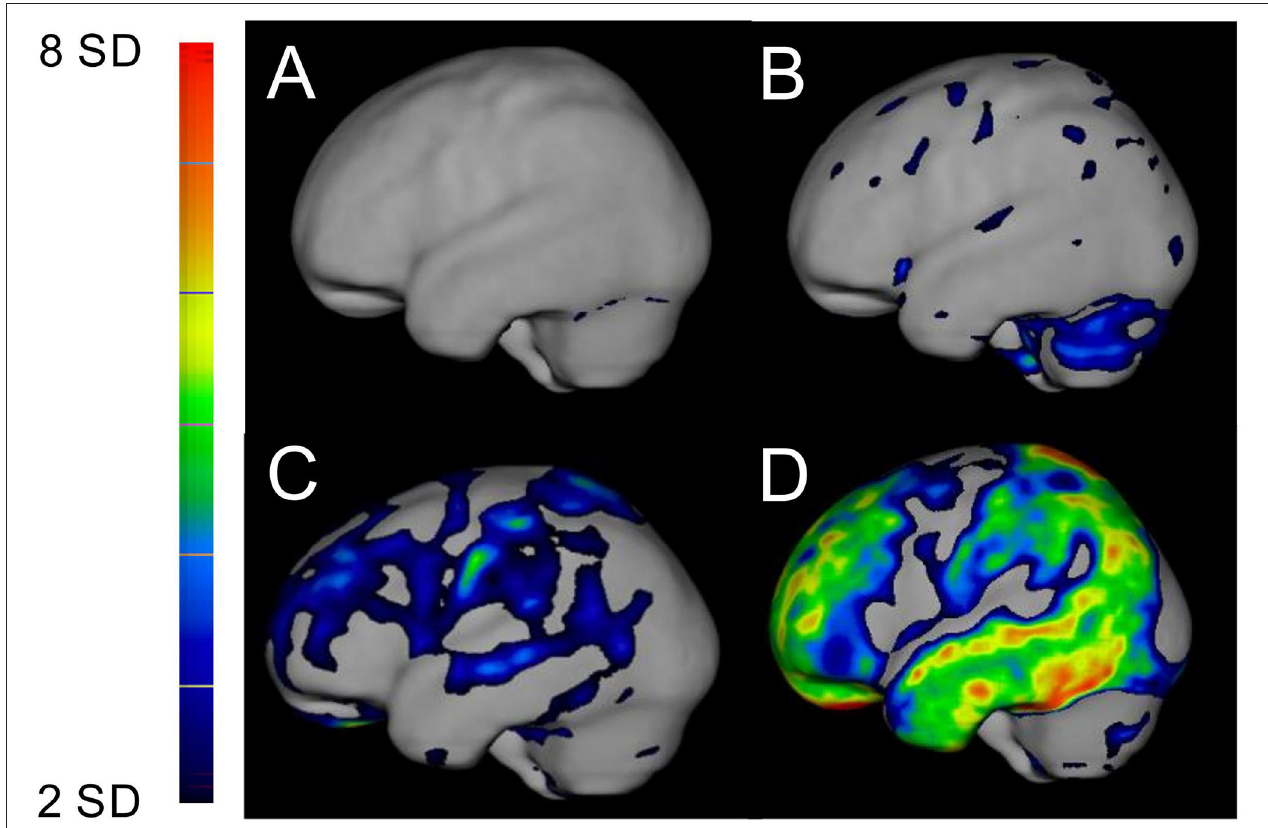
FIGURE 1 | PET/CT examination of [ 18 F]flutemetamol shown as Z-score in the brain in relation to pons from a left lateral view of the brain. The intensity of the uptakes is visualized on the left panel and is graded from low increased uptake in blue (Z-score + 2SD) to high increased uptake in red (Z-score + 8SD). (A) An ATTR V30M patient with 15 years of disease showing no increased uptake; (B) an ATTR V30M patient with 16 years of disease showing increased uptake in the cerebellum, (C) an ATTR V30M patient with 27 years of disease showing diffuse increased uptake in the brain, and (D) an Alzheimer’s patient with generalized increased uptake in the frontoparietotemporal